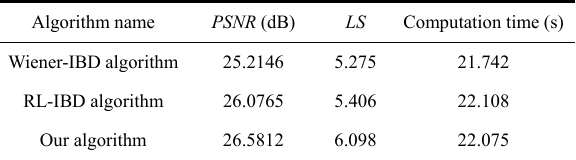
Table 1 PSNR , LS , and the computation time comparison for the three algorithms for chemical plant images restoration.